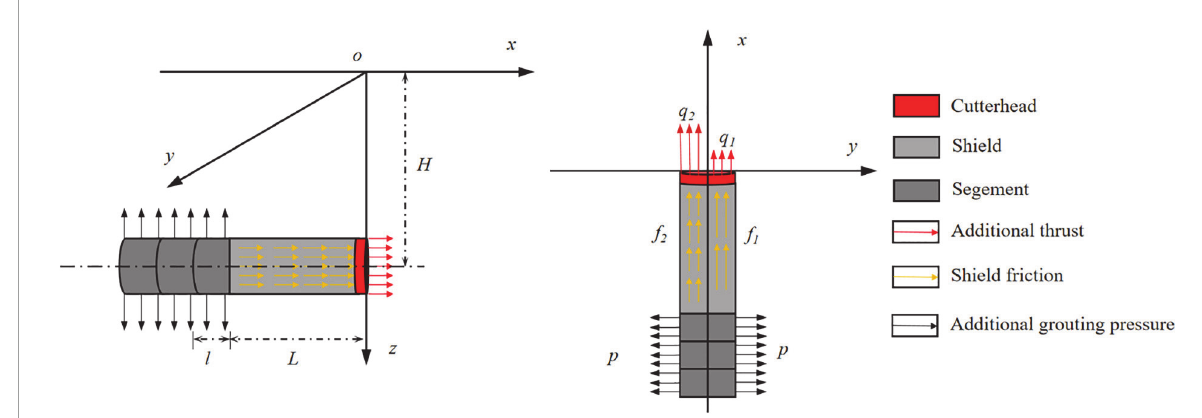
FIGURE1 Load distribution of shield machine tunnelling.